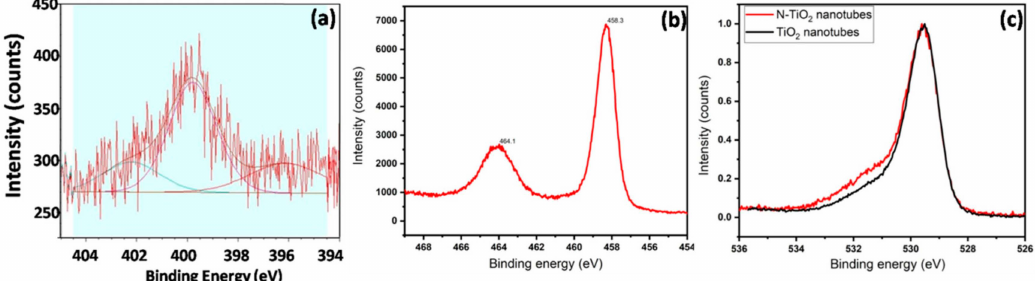
Figure 5. Narrow scan XPS spectra of ( a ) N 1s, ( b ) Ti 2p and ( c ) O 1s of N-TiO 2